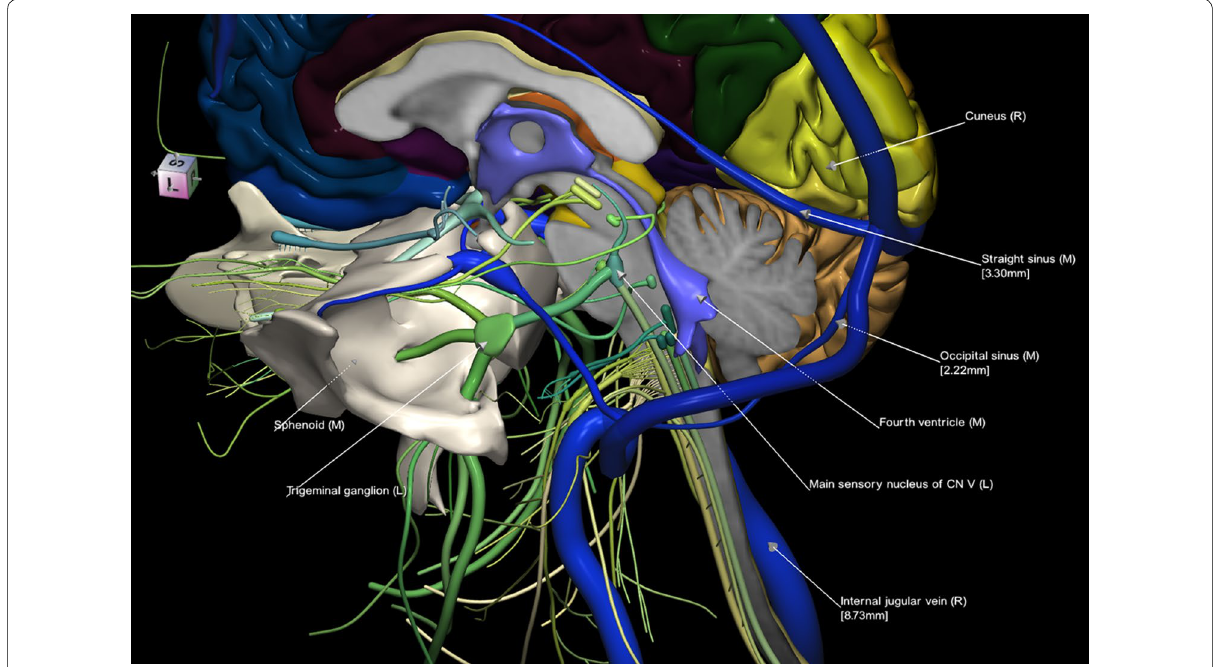
Fig. 8 Sphenoid along with the brainstem and surrounding structures; some of them are